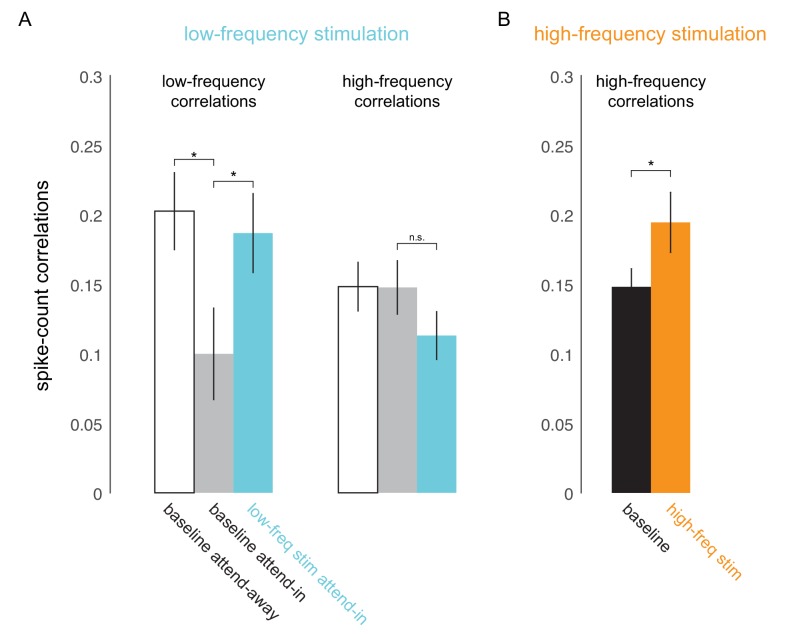
Optical stimulation at low- and high-frequencies induces low- and high-frequency correlated activity.(A) Consistent with earlier reports (Mitchell et al., 2009), attention reduces baseline spike-count correlations at low frequencies (200ms counting window, p=0.02; left panel, white versus gray bar) but not at high frequencies (50ms window; right panel, white versus gray bar). Low-frequency optical stimulation increases low-frequency correlations (p=0.045; left panel, gray versus blue bar) but not high-frequency correlations (p>0.1; right panel, gray versus blue bar). (B) High-frequency optical stimulation increases high-frequency correlations (p<0.05). n=79 pairs for baseline and low-frequency stimulation, n=27 pairs for high-frequency stimulation, collapsed across attention conditions. Mean +/- s.e.m. in all plots.